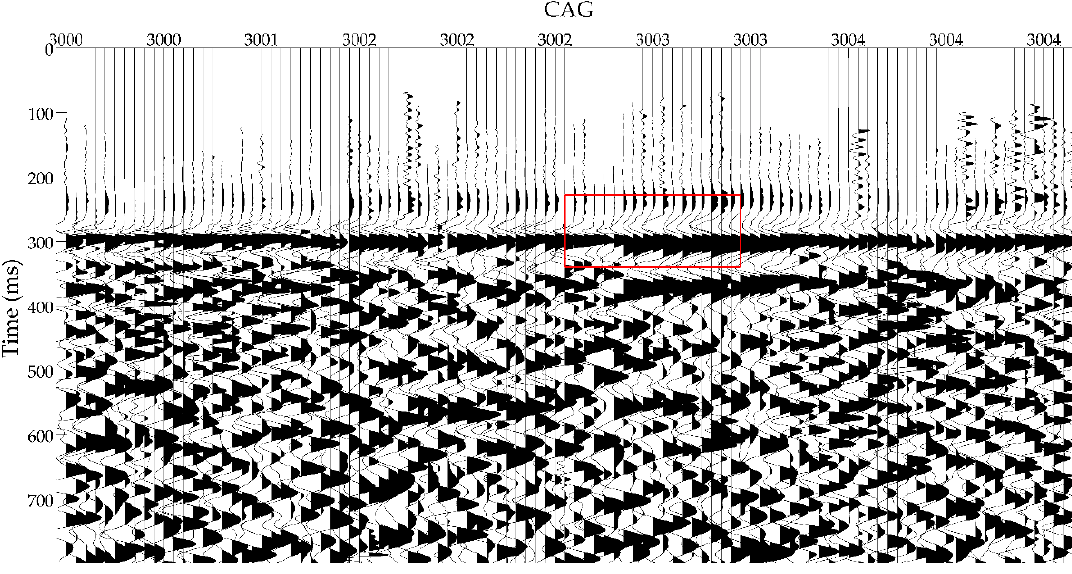
Figure 9 . CRG (No. 825) after static correction based on CAGs.